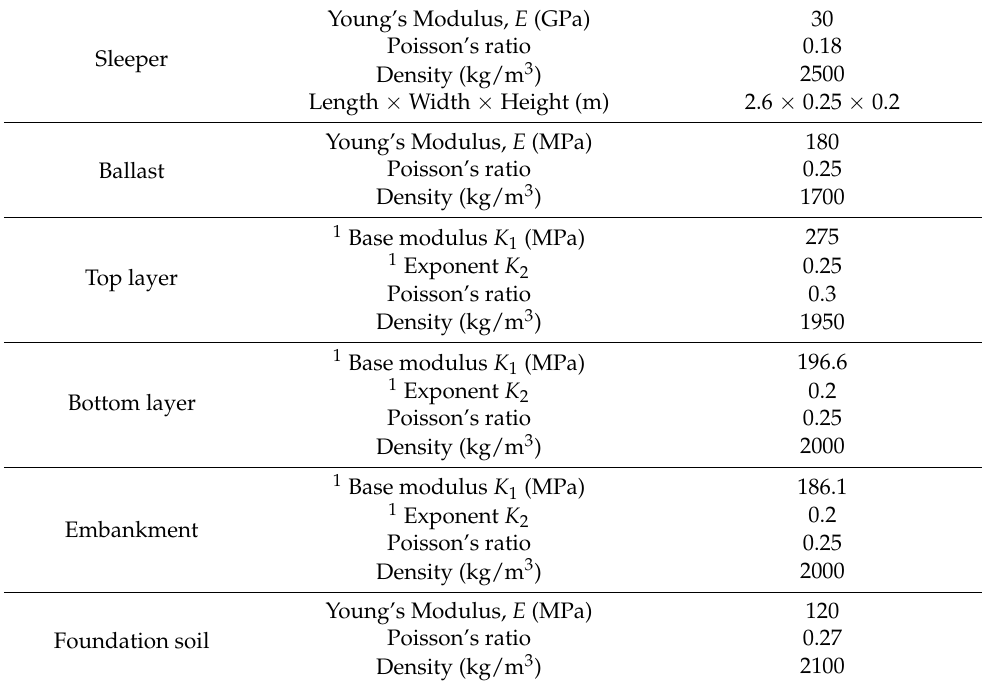
Table 1. Properties of track component materials.